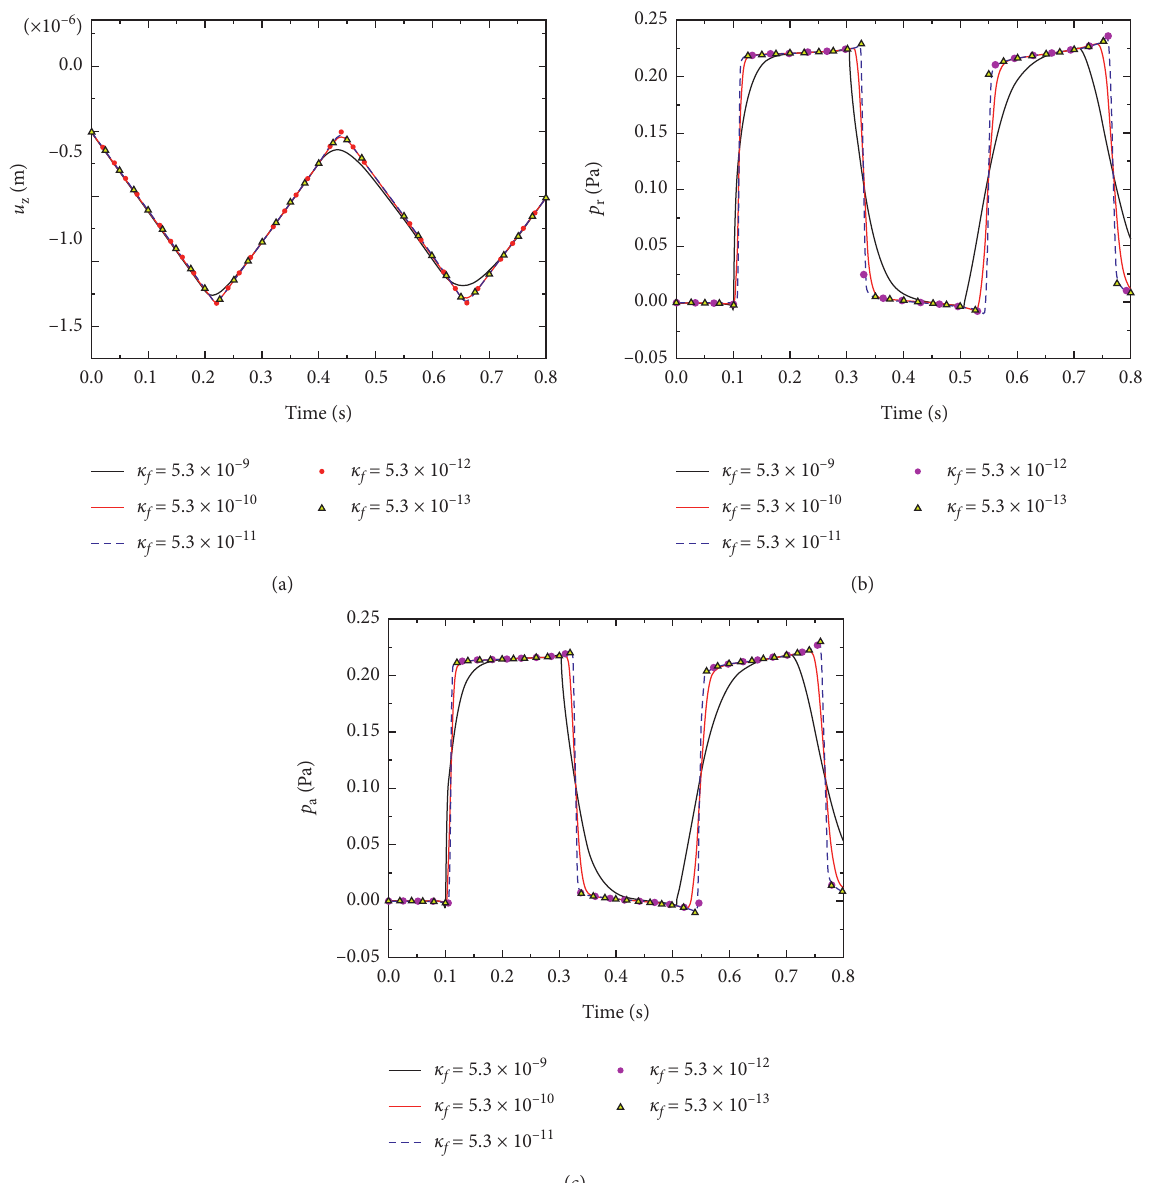
� L ), fluid pressure p � 0), and air pressure p � 0) with time z ( t , z f ( t , z a ( t , z